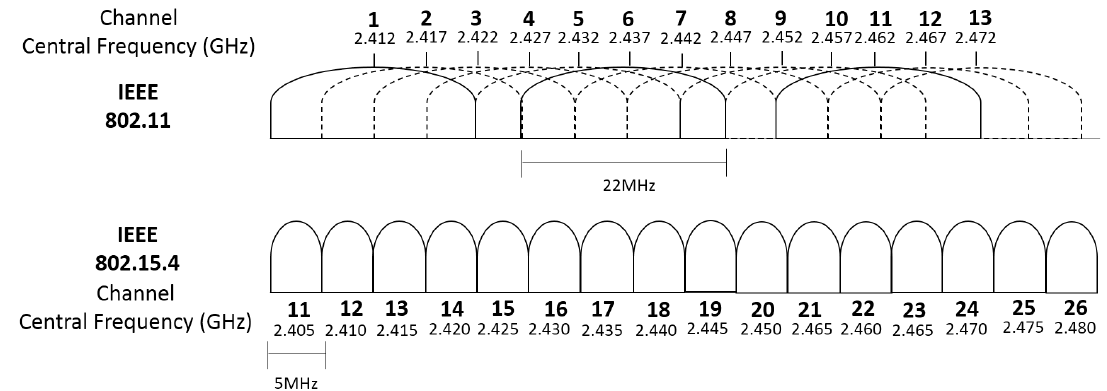
Figure 11. Variation in IEEE 802.11 throughput as new 802.15.4 motes are added to the